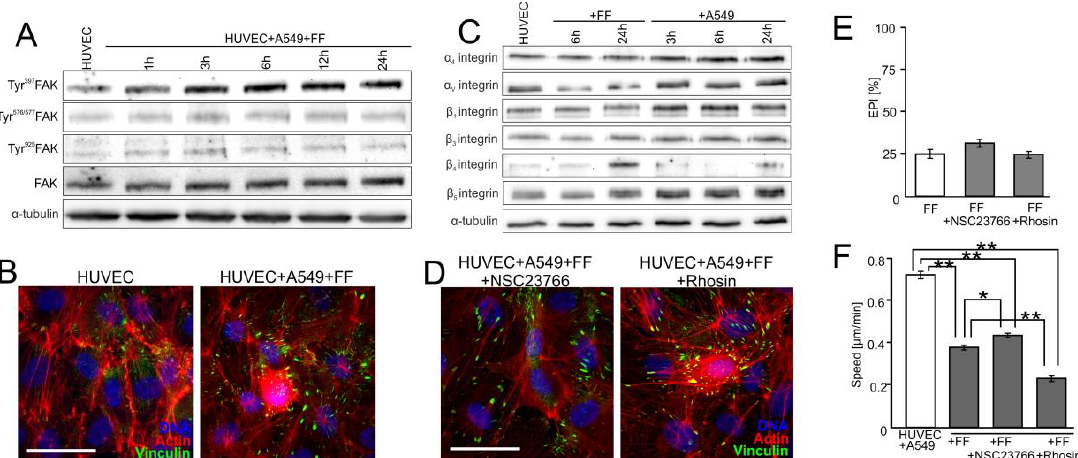
Figure 5. FF directly attenuates HUVEC susceptibility to the activating signals generated by A549 cells. ( A ) HUVEC/A549 co-cultures were established as in Figure 1 and cultivated in the presence of 25 μM FF. Tyr 397 FAK, Tyr 576/577 FAK, and Tyr 925 FAK were analyzed at the indicated time points by immunoblotting and quantified by densitometry (Figure S5E). ( B ) Cytoskeletal architecture in HUVECs (Figure 3A) in A549/HUVEC co-cultures visualized by immunostaining in the absence (left) or presence of 25 μM FF (6 h; right). ( C ) HUVECs were cultivated in the presence of 25 μM FF or A549 cells and the levels of integrins were estimated at the indicated time points by immunoblotting and quantified by densitometry (Figure S5F). ( D ) The effect of NSC23766 (left) or Rhosin (right) on the cytoskeletal architecture of HUVECs cultured in the presence of A549 cells and 25 μM FF (see B for control). ( E ) Effect of NSC23766, Rhosin, and FF on the efficiency of A549 diapedesis (TransEndothelial Penetration; EPI), estimated after 6 h of A549/HUVEC co-culture. Transmigration of at least 200 A549 cells was analyzed for each group. ( F ) Effect of NSC23766 and Rhosin on the motility of proximal HUVECs analyzed in the presence of FF by time-lapse videomicroscopy. Error bars represent SEM. The statistical significance of the differences was tested with one-way ANOVA followed by post-hoc Tukey’s HSD ( E ) or non-parametric Dunnett comparison ( F ); * p < 0.05; ** p < 0.01 against the control or # p < 0.05 against HUVEC/A549 control (see Figures 4B and S5D). All results are representative of at least three independent experiments ( n ≥ 3). Scale bar = 40 μm. Note that the inhibition of RhoA and Rac1 slightly counteracts FF-induced maturation of focal adhesions while inhibiting A549 diapedesis and HUVEC motility.